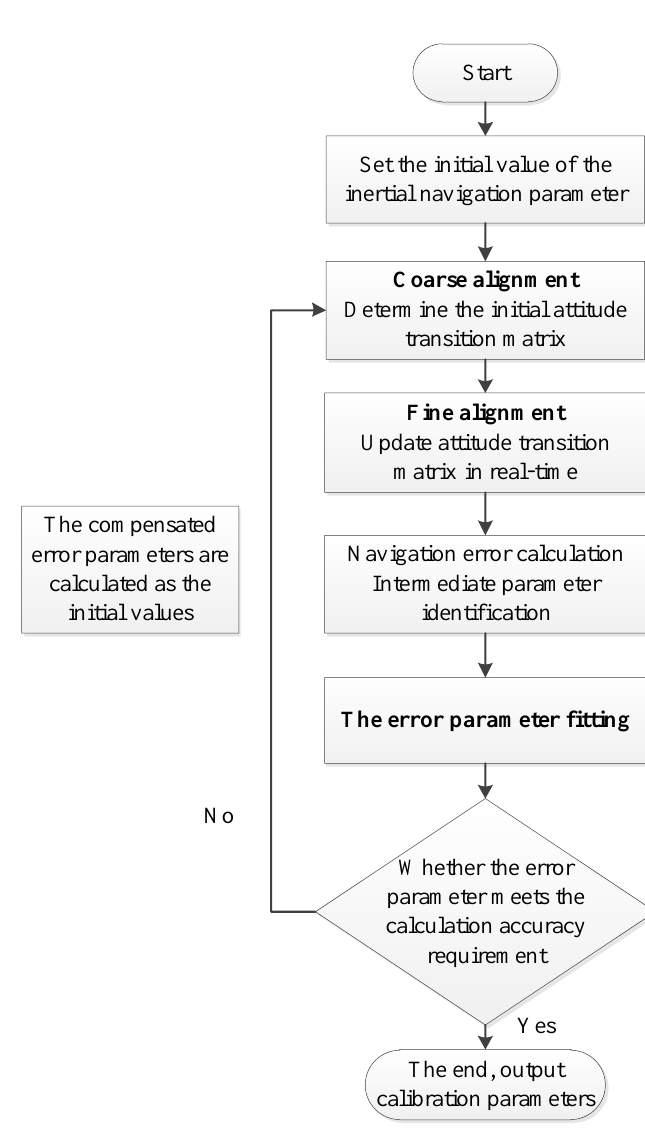
Figure 3. Self-calibration method process.